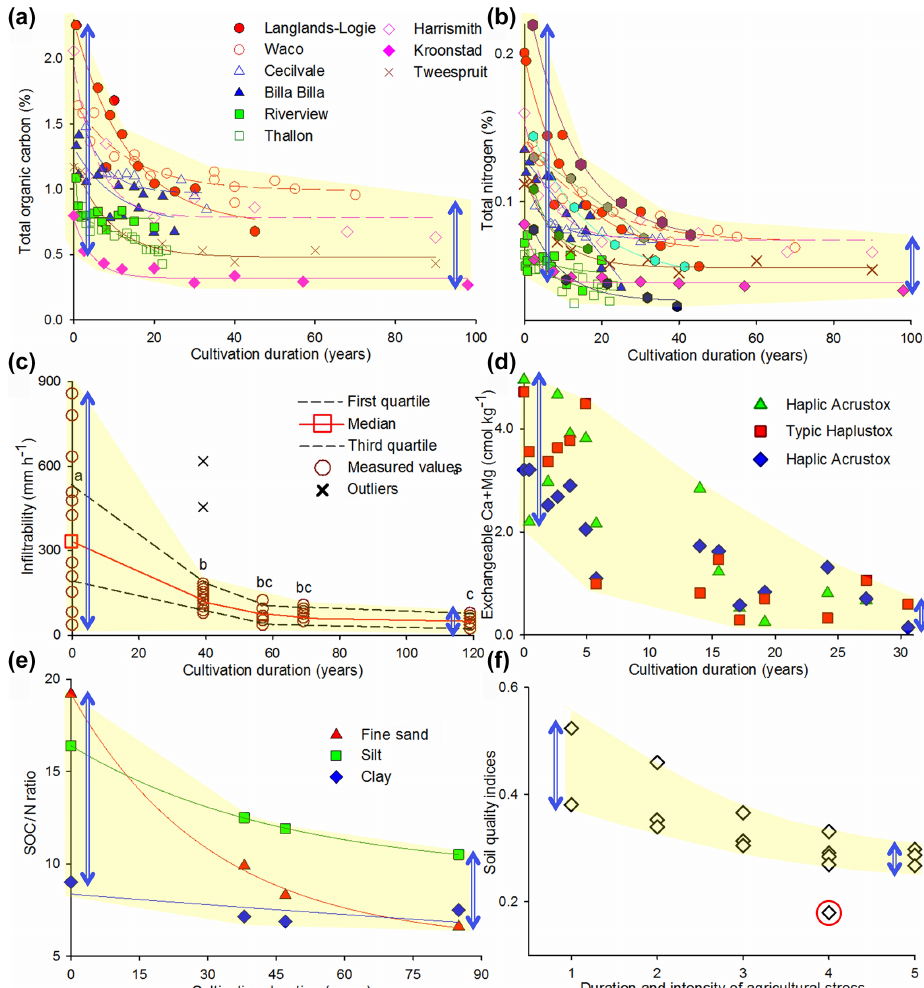
Figure 3. Examples for attractors of soil properties by anthropogenic degradation: (a) soil organic carbon content, (b) total nitrogen content, (c) infiltration rates, (d) exchangeable Ca 2 + and Mg 2 + contents, (e) C : N ratio, and (f) overall decrease in soil quality, i.e. degradation over the cultivation period. Yellow shading area: covering all experimental points, showing a decrease in the area with cultivation duration. Blue double arrows: range of data points in natural soils (left of each panel) and strong decrease in data range due to cultivation (right of each panel). (a) Narrowing range (blue arrows) of soil organic C over cultivation periods in southern Queensland, Australia (six sites; Dalal and Mayer, 1986a), and savanna soils in South Africa (three sites; Lobe et al., 2001). The natural soils in different climatic regions have various ranges of properties, e.g. organic C from 0.8% to 2.3%. During cultivation, however, the organic C content strongly narrows to between 0.3% and 1.0%. (b) Narrowing range (blue arrows) of total soil N over cultivation periods. Sampling sites similar to (a) plus five sites (hexagons) from the Great Plains, USA (Haas et al., 1957). Before agriculture start, the Great Plains soils had a wide range of of 0.05%–0.22%. Nonetheless, the total N range narrowed to 0.03%–0.07% over 45 years of intensive agriculture. As Haas et al. (1957)